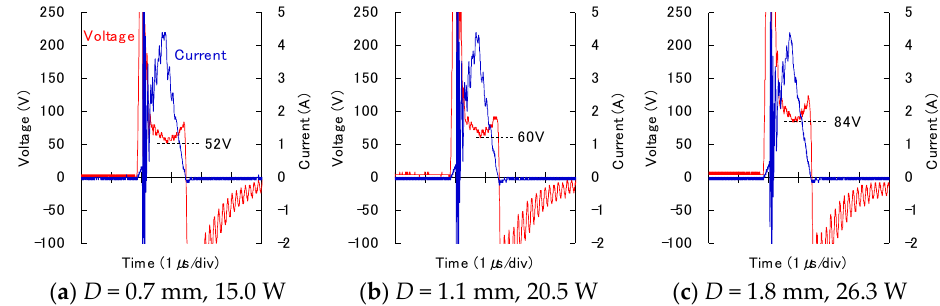
Figure A1. Current – voltage waveforms of one-pulse discharge for various electrode distances D . Figure A1. Current–voltage waveforms of one-pulse discharge for various electrode distances D